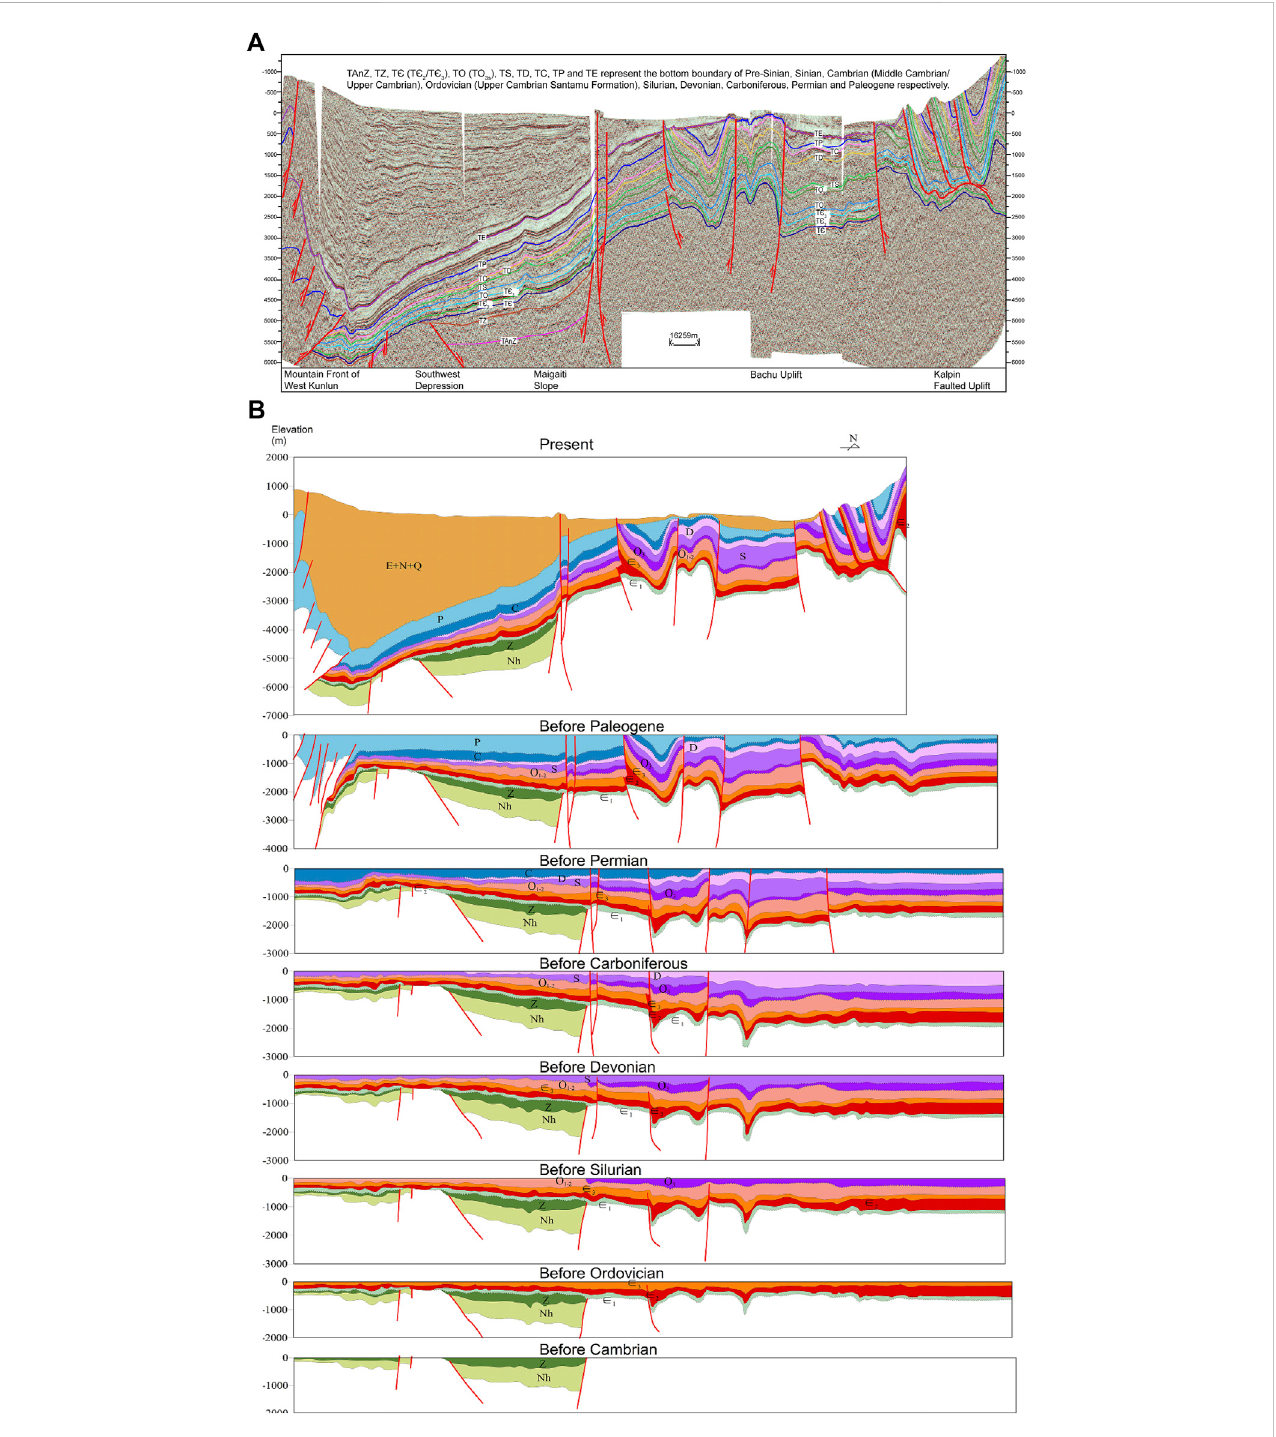
FIGURE 5 Geological interpretation of seismic section NS08 (A) and its recovered balanced cross-section (B) . The location of seismic section NS08 is shown in Figure